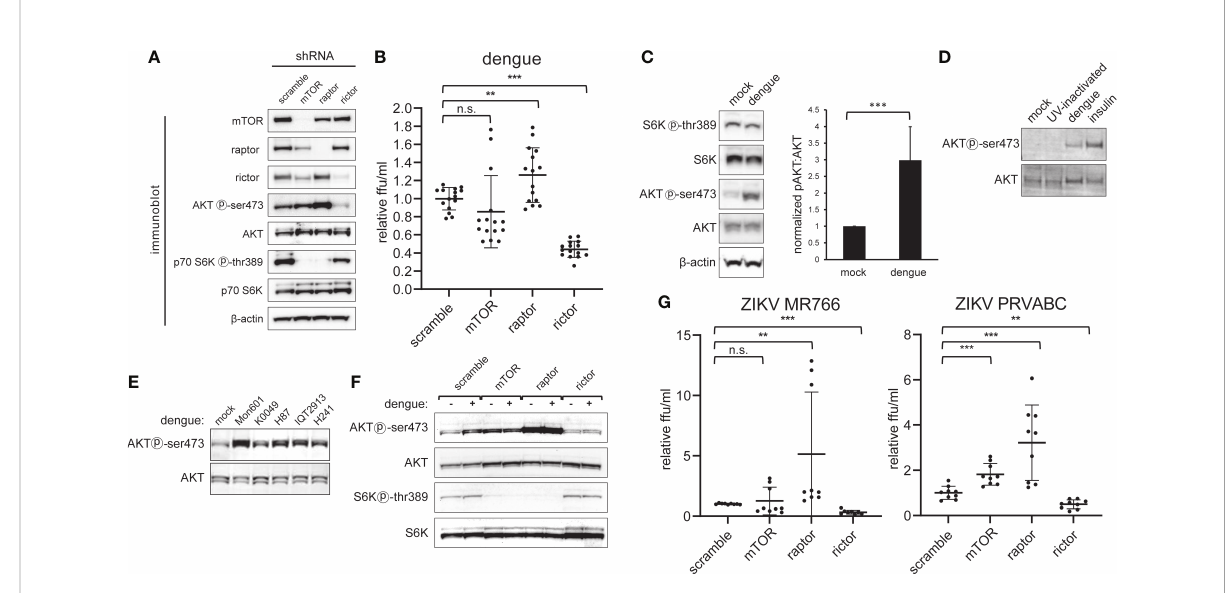
FIGURE 2 Dengue infection activates mTORC2 signaling and is required for maximal viral replication. A , Selective inactivation of mTORC1 and mTORC2 in HepG2 cells. Cells were transduced with lentivirus encoding shRNA directed against mTOR protein, Raptor, or Rictor, or with a non-speci fi c scramble sequence, and then selected with puromycin. Lysates were analyzed by western blot with the indicated antibodies. B , mTORC2 inactivation diminishes dengue replication. Cells were transduced with lentiviral shRNA vectors as in (A) and were then infected with dengue MON601 at a MOI of 1. 24 h later cell culture supernatants were collected and titrated on Vero cells. The data represent scramble-normalized values from 4 independent experiments. (C) , mTORC2 is activated during dengue infection. HepG2 cells were infected with dengue at MOI of 4. Cells were collected at 36 h post-infection and analyzed by western blot with the indicated antibodies. The bar graph shows the ratio of phospho-AKT to total AKT band intensity averaged from 7 independent experiments. (D) , Competent dengue virus infection is required for AKT activation. HepG2 cells were infected with dengue at a MOI of 1, or with UV-inactivated virus. Mock and insulin treatment were used as a negative and positive control for AKT activation, respectively. Lysates were analyzed by western blot with the indicated antibodies. (E) , mTORC2 activation is conserved across dengue serotypes. Experiments were performed as in (C) using Huh7 cells infected with DENV-2 MON601, DENV-2 K0049, DENV-3 H87, DENV-2 IQT2913, or DENV-4 H241. (F) , Rictor knockdown abrogates mTORC2 activation by dengue. Cells were transduced with shRNA encoding lentivirus as in (A) and were infected with dengue at MOI of 4. Cells were collected at 36 hpi and were analyzed by western blot with the indicated antibodies. (G) mTORC2 abrogation negatively impacts Zika virus (ZIKV) replication. Experiments were performed as in (B) but with ZIKV MR788 and ZIKV PRVABC. Error bars are one standard deviation. p values are derived from 2-tailed Student ’ s t test; n.s., not signi fi cant; ** denotes p < 0.01, and *** denotes p <